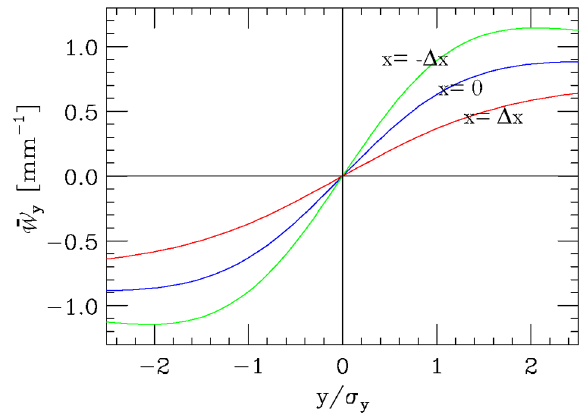
FIG. 7. (Color) For LCLS spoiler parameters: (cid:27) WW (cid:3) (cid:1) x , 0, and (cid:1) x